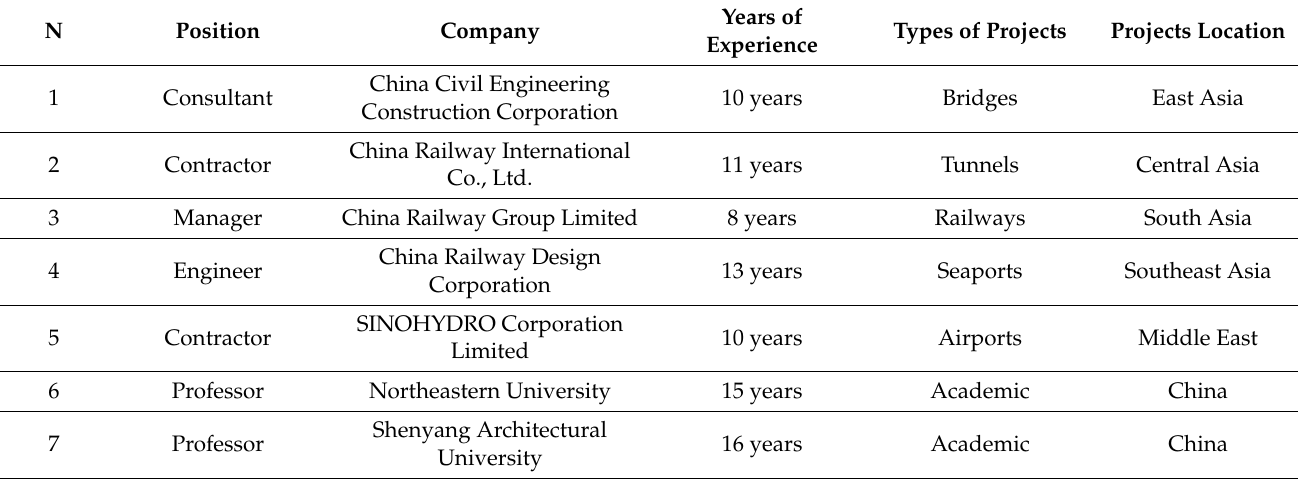
Table 1. Profile of the selected participants for the semi-structured